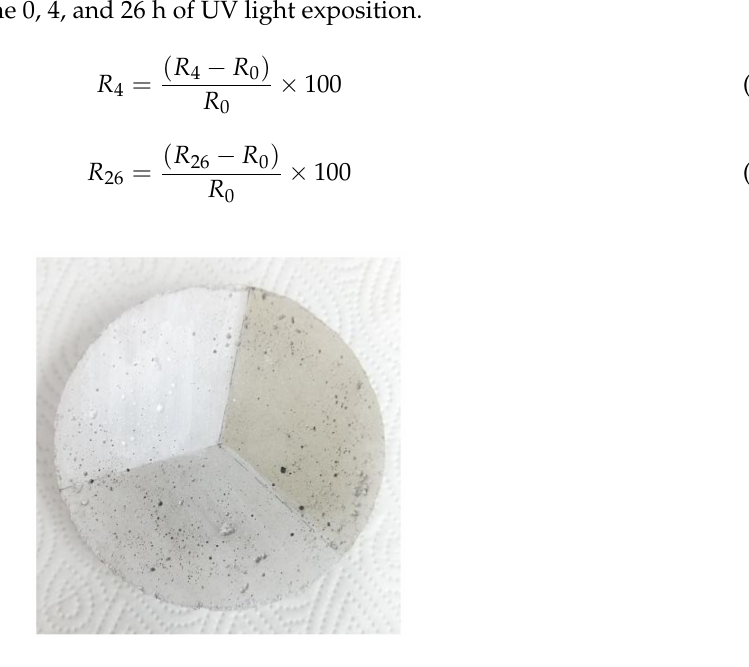
Figure 1. Mortar surface coated with TiO 2 , SiO 2 and SiO 2 @TiO 2 coatings.